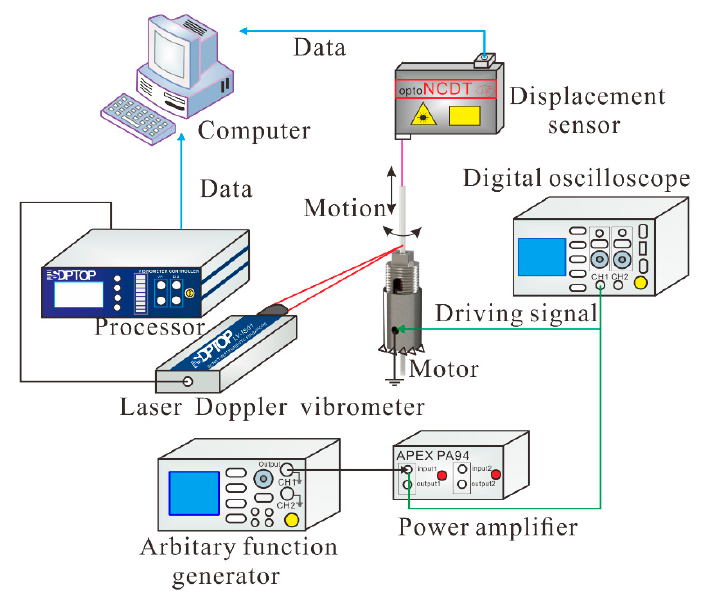
Figure 6. Schematic diagram of experimental testing system of prototype motor.